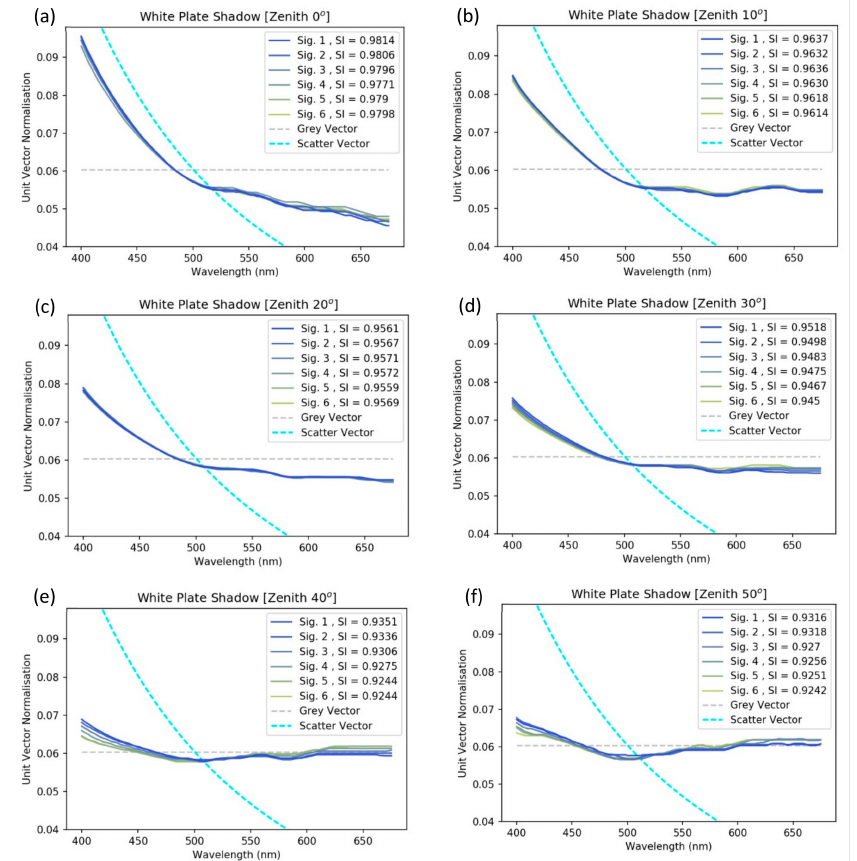
Figure 8. FR Spectroradiometer shadow signatures in unit vector form for six zenith angles. The scattering index (SI) values for each signature are provided in legends. The grey vector and the scatter vector λ − 2.6945 are provided for reference. Plates ( a ), ( b ), ( c ), ( d ), ( e ), and ( f ) are zenith angles 0 ◦ , 10 ◦ , 20 ◦ , 30 ◦ , 40 ◦ , and 50 ◦ ,